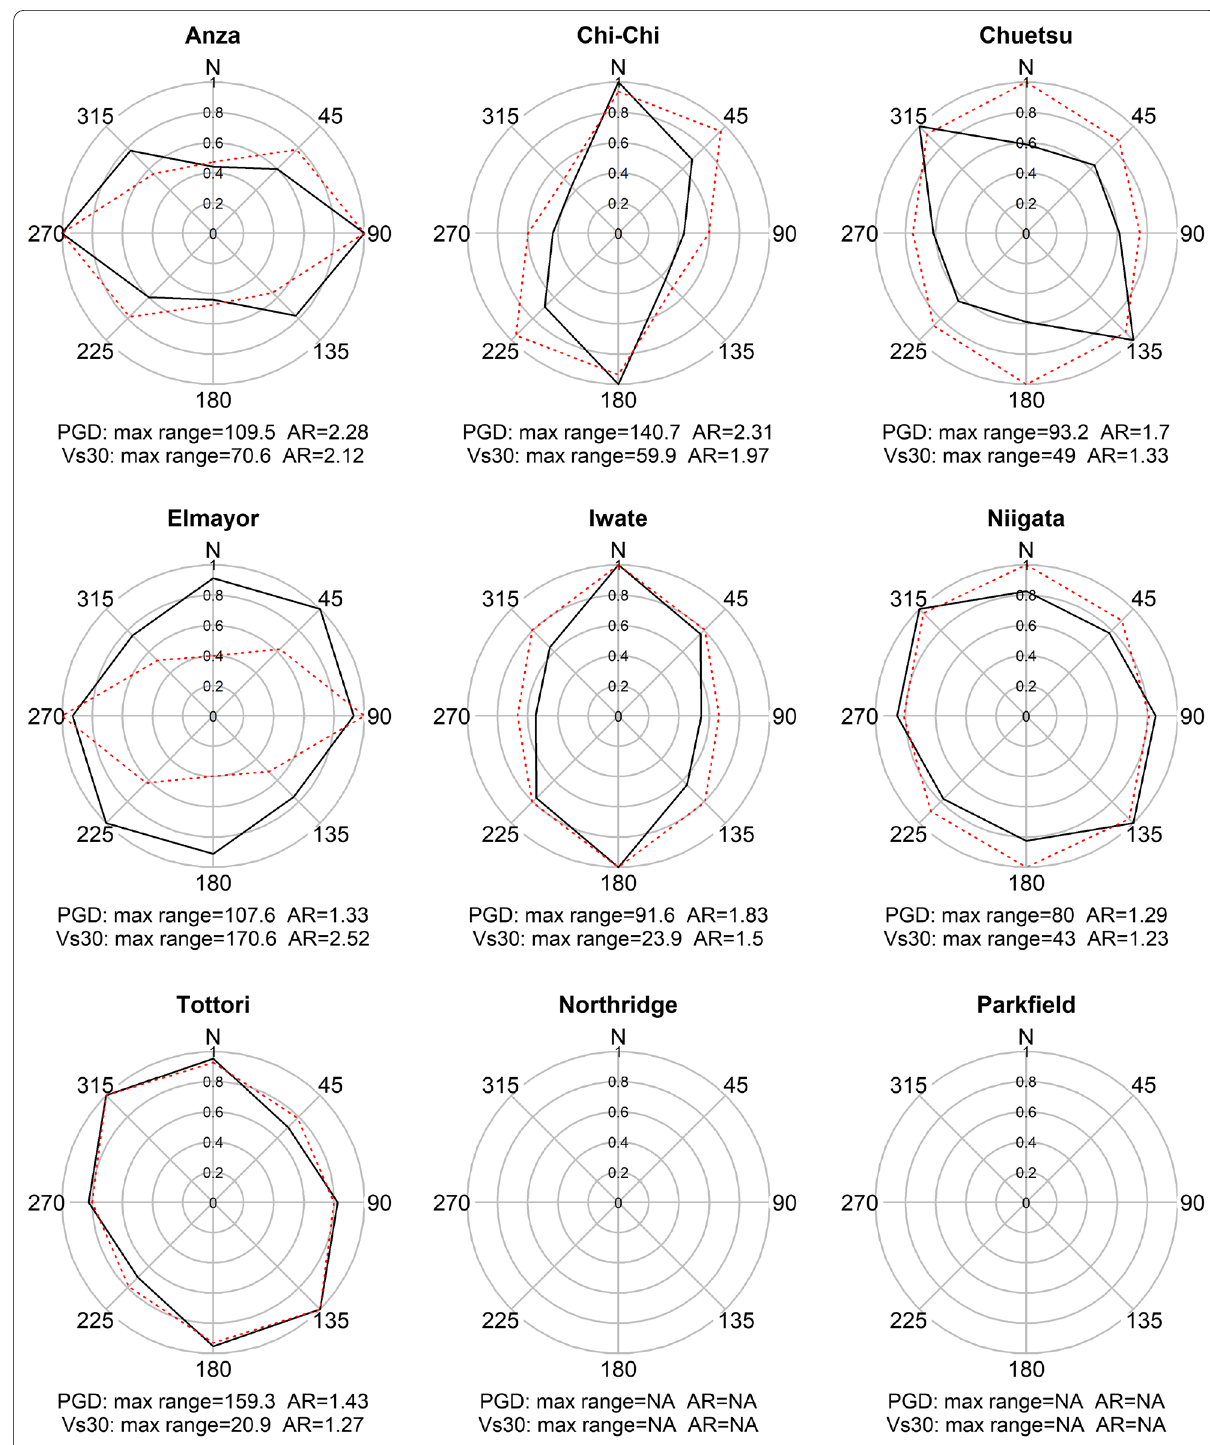
Fig. 10 Rose diagrams of normalized ranges of the directional semivariograms of the residuals of the PGD (solid lines) and normalized V s30 (dashed lines) values at record stations of different